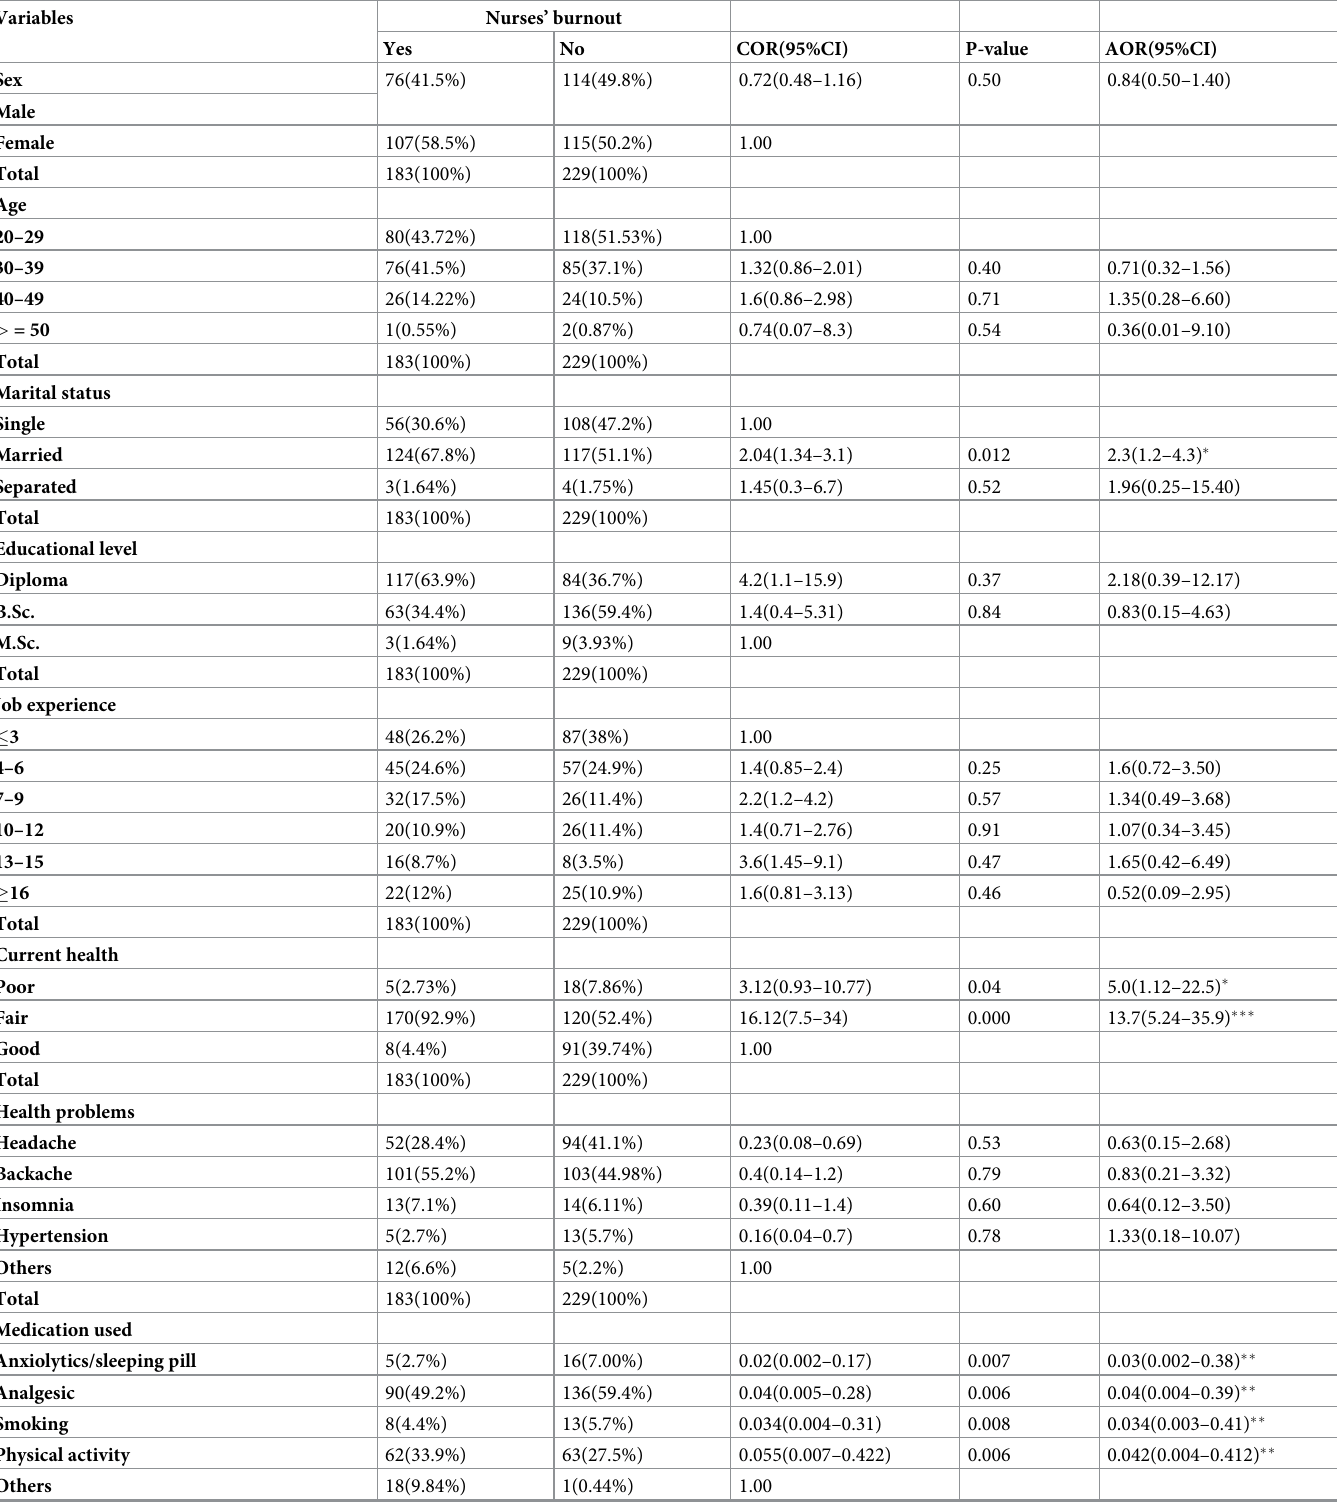
Table 4. Factors associated with burnout among nurses who were working in Harari regional State and Dire Dawa administration, Ethiopia, 2020(n =